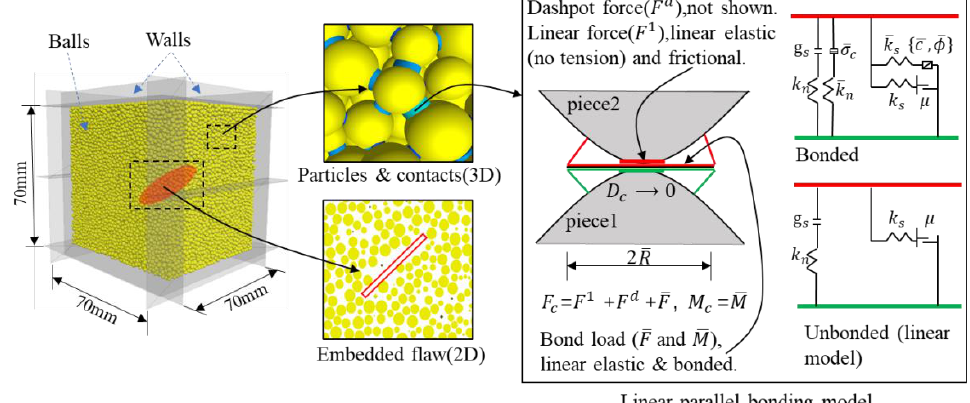
Figure 11. PFC3D model sample and parallel bonding model.